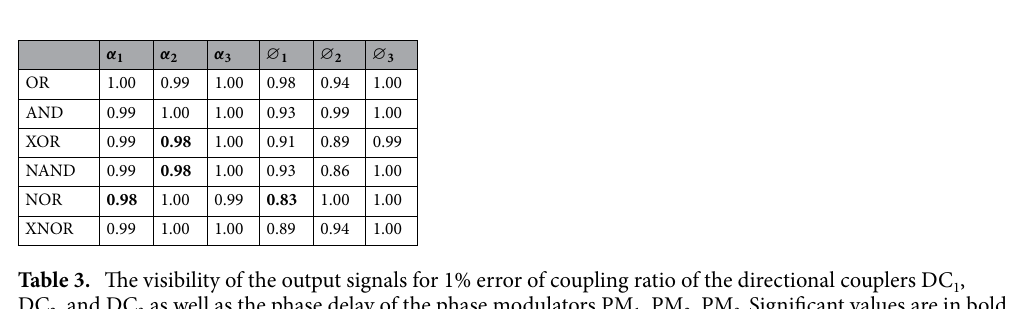
Table 3. The visibility of the output signals for 1% error of coupling ratio of the directional couplers DC 1 , DC 2 , and DC 3 as well as the phase delay of the phase modulators PM 1 , PM 2 , PM 3. Significant values are in bold.